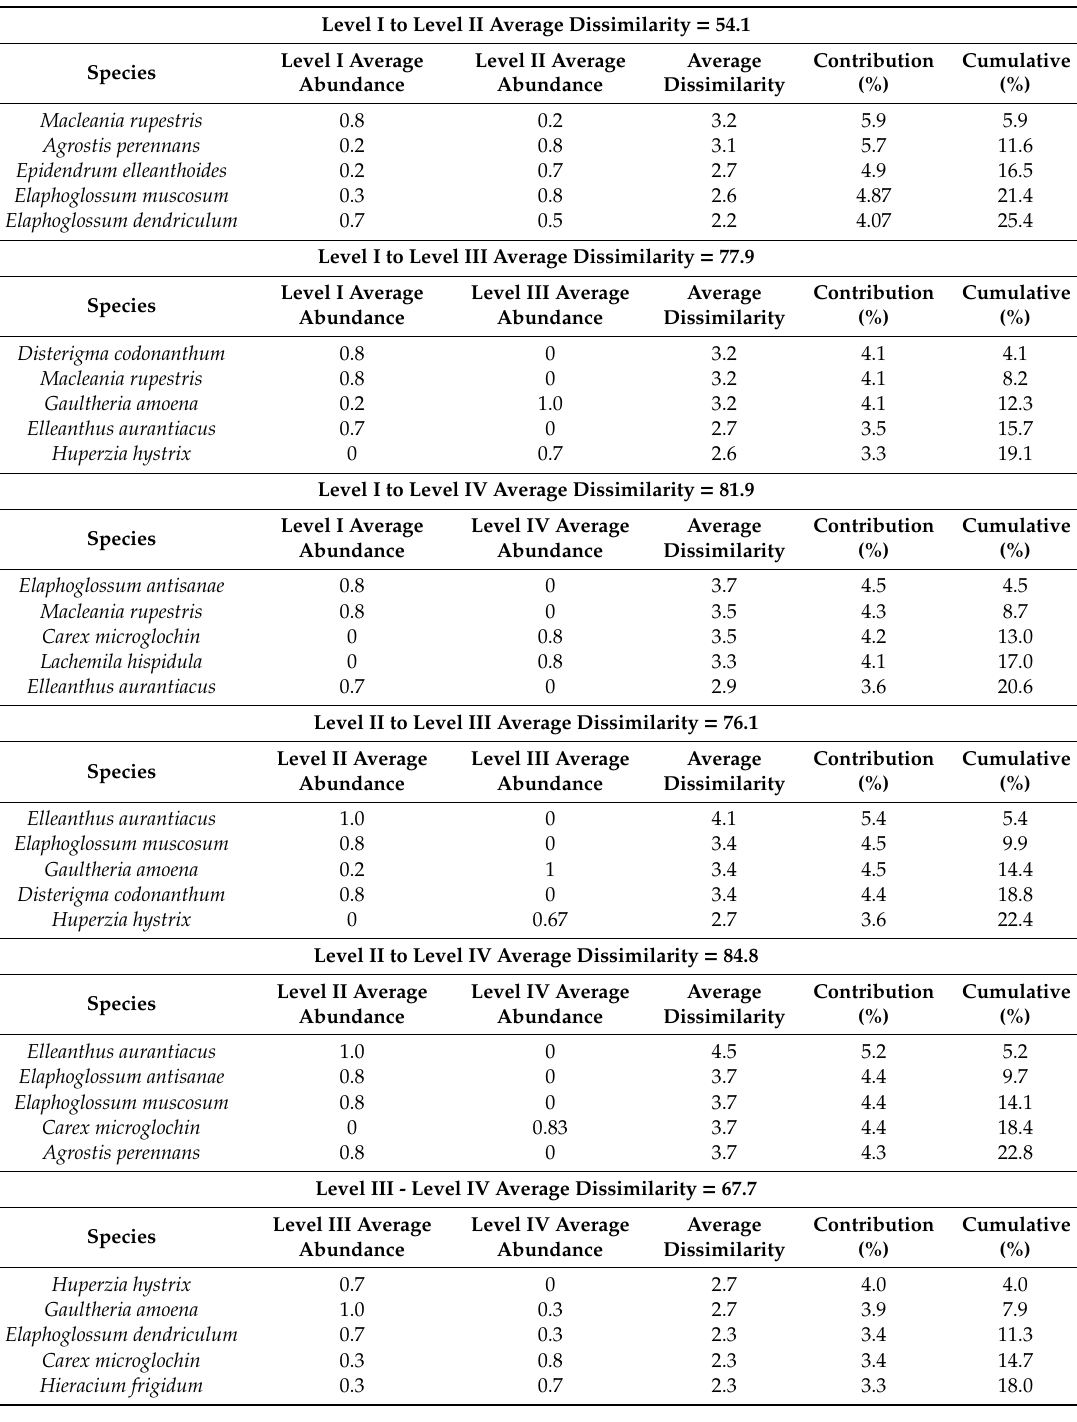
Table 3. Species and values of floristic dissimilarity between primary levels of